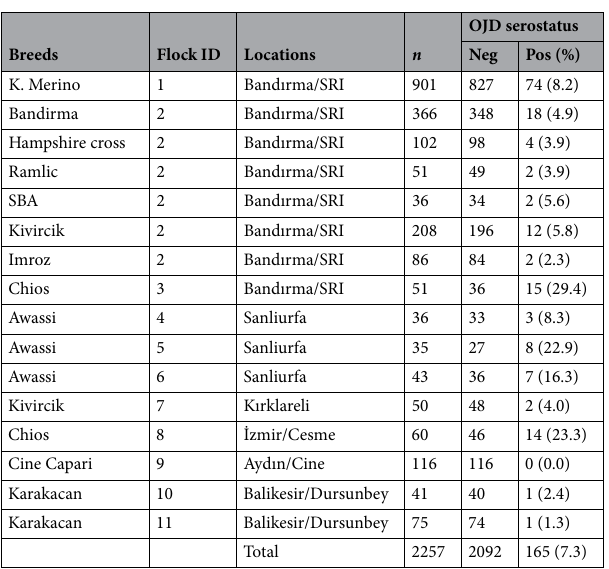
Table 1. Seroprevalence of OJD. ID identifier; K Karacabey; n number; OJD ovine Johne’s disease; Neg negative; Pos positive; SRI Sheep Breeding and Research